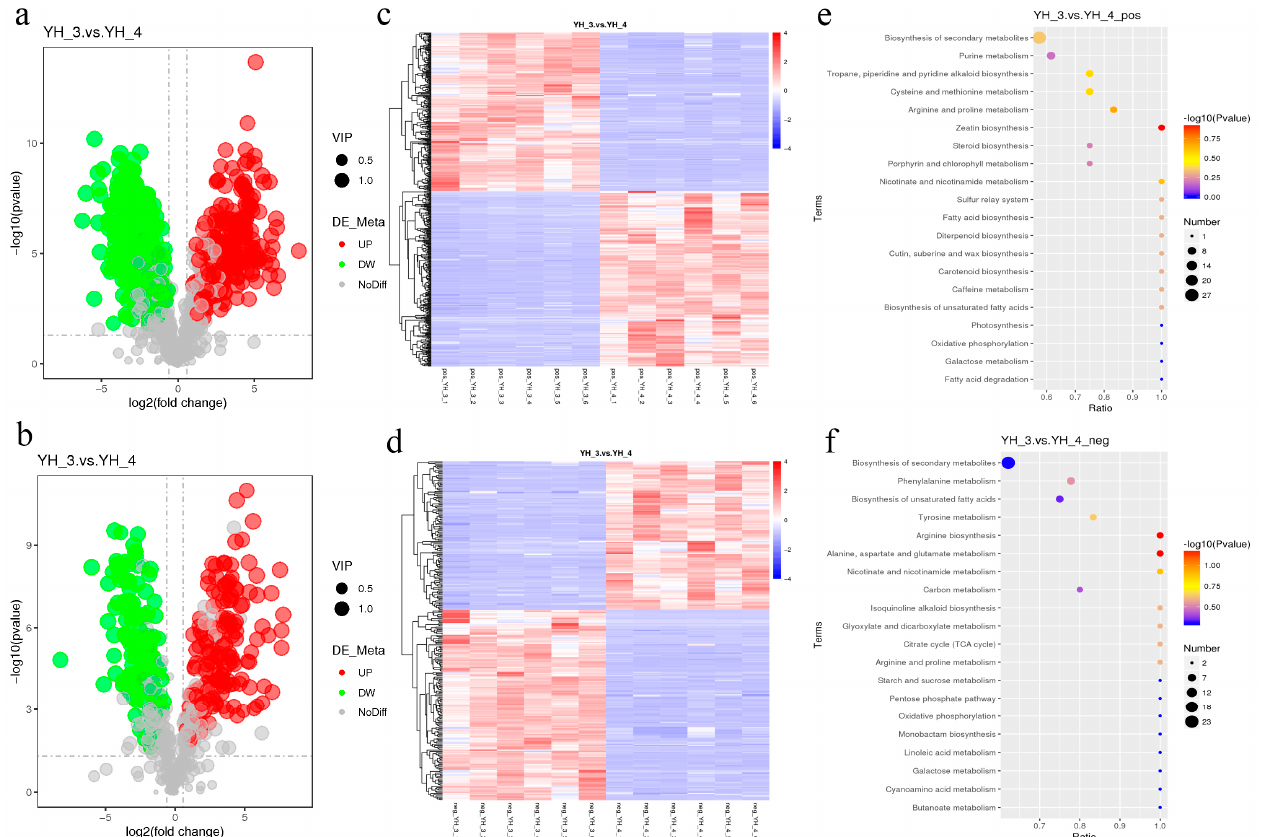
Figure 4. DAMs analysis in YH_3 vs. YH_4. ( a ) Volcano plot of differential metabolites in positive polarity mode. ( b ) Volcano plot of differential metabolites in negative polarity mode. Each point in the volcano map represents a metabolite, and the X-axis represents the logarithm of the quantitative difference of a certain metabolite in the two samples; the Y-axis represents the significance level of the difference ( − log10p value). The green dots represent downregulated DAMs, the red dots represent upregulated DAMs, and the gray dots represent DAMs that were not significantly changed. ( c ) HCA of DAMs in YH_3 vs. YH_4 in positive polarity mode. ( d ) HCA of DAMs in YH_3 vs. YH_4 in negative polarity mode. ( e ) Scatter plot of KEGG pathways enriched in YH_3 vs. YH_4 in positive polarity mode. ( f ) Scatter plot of KEGG pathways enriched in YH_3 vs. YH_4 in negative polarity mode. The abscissa in the figure represents the ratio of the number of differential metabolites in the corresponding metabolic pathway, to the number of total metabolites identified in the pathway. The greater the value, the higher the degree of enrichment of differential metabolites in the pathway. The color of the point represents the p -value value of the hypergeometric test. The smaller the value, the greater the reliability and statistical significance of the test. The size of the point represents the number of differential metabolites in the corresponding pathway. The larger the point, the more differential metabolites in the pathway.